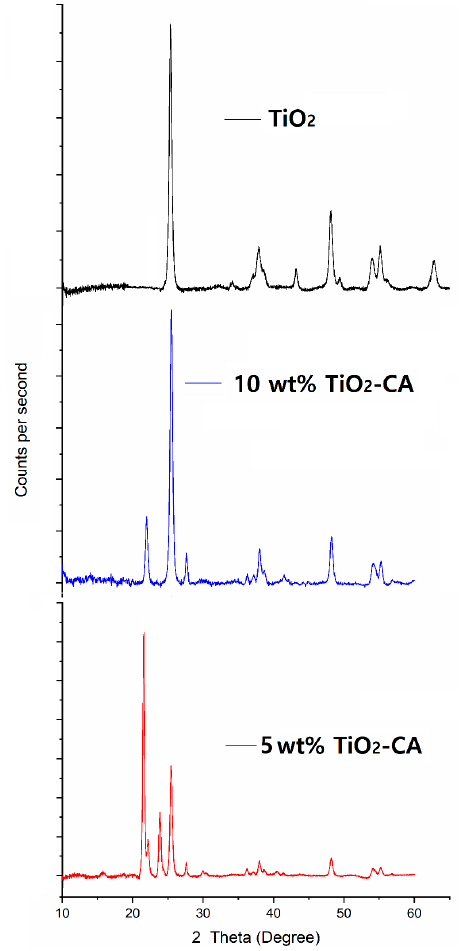
Figure 3. XRD patterns of synthesized TiO 2 nanoparticles, and 5 and 10 wt% TiO 2 -CA nanofibers. Table 2. XRD analysis of synthesized TiO 2 nanoparticles and TiO 2 -CA nanofibers.